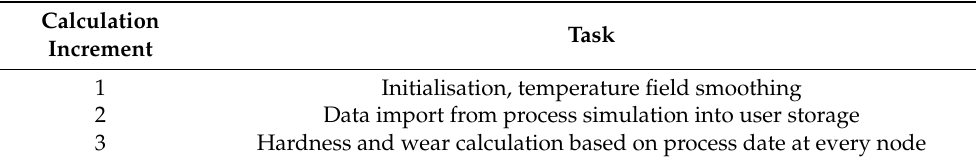
Table 6. Execution order of the improved wear